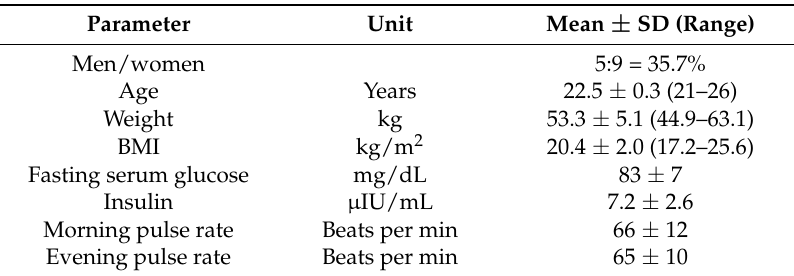
Table 1. Baseline parameters of the participants on an unrestricted